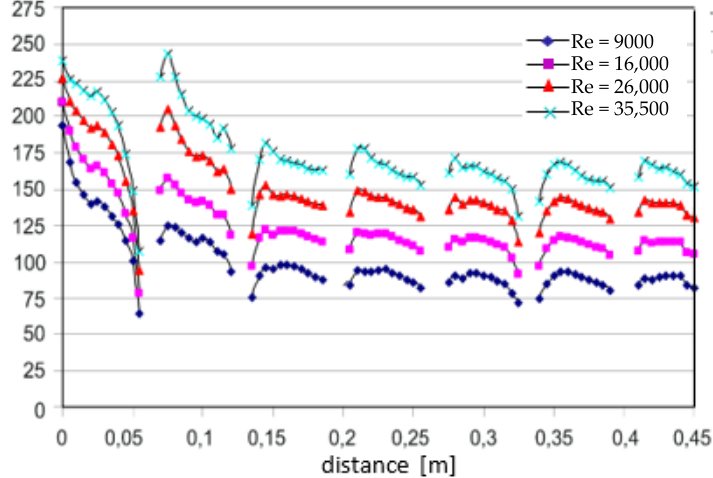
Figure 19. Local Nusselt number distribution for different Re numbers for a channel with slanted ribs on the bottom surface of the channel (configuration_3).